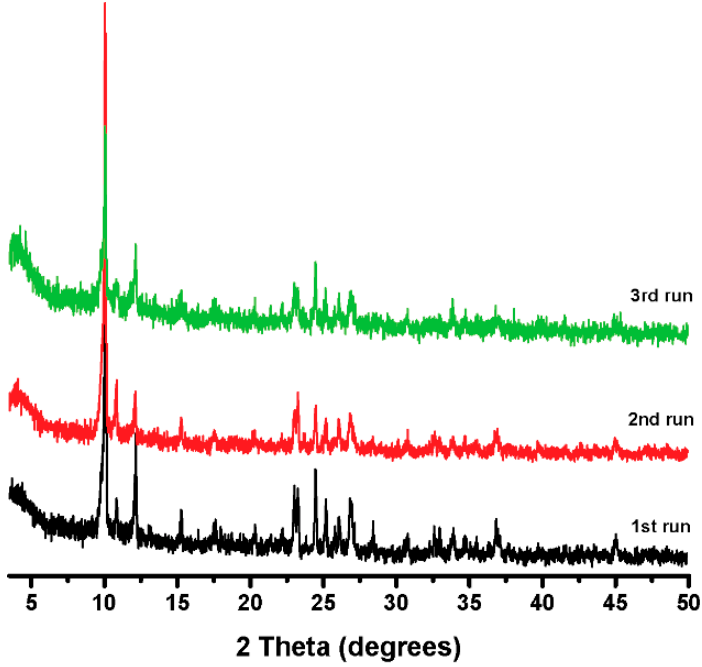
Figure 9. Powder X-ray diffraction patterns of the consecutively used catalyst in the Fur/Gly reaction at 50 ° C.